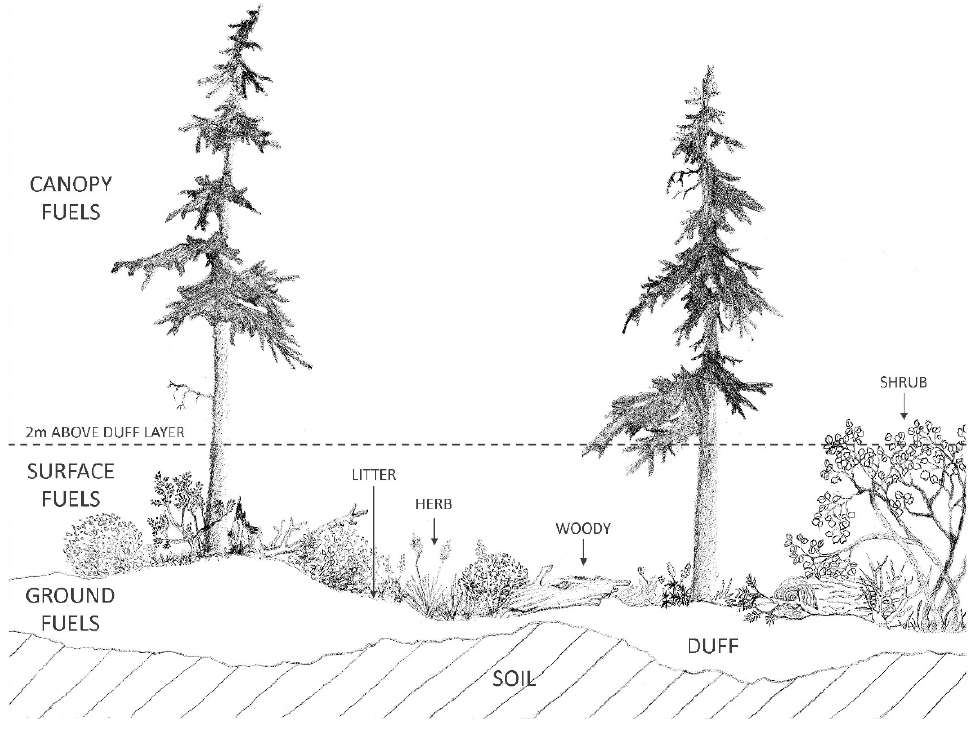
Figure 1. Illustration of a wildland forest fuelbed showing the three major strata: ground, surface, and canopy fuels from Keane [9] and drawn by Ben Wilson.